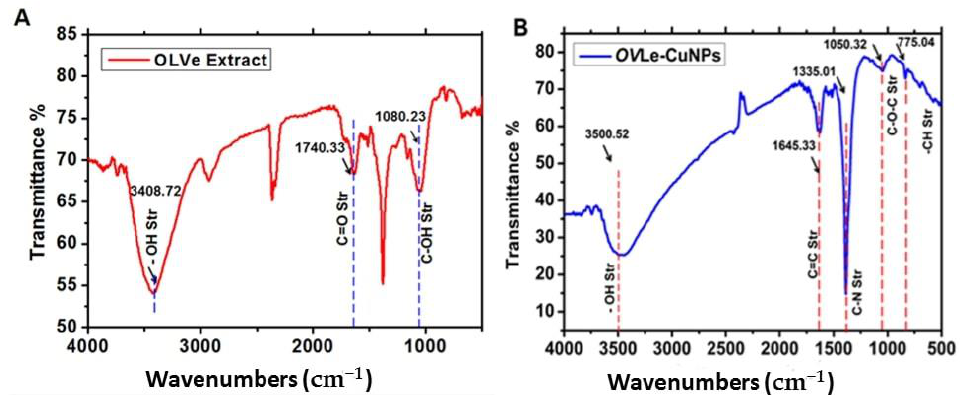
Figure 3. FTIR spectra: ( A ) Olive leaf extract (OVLe), ( B ) CuO @OVLe NCs.